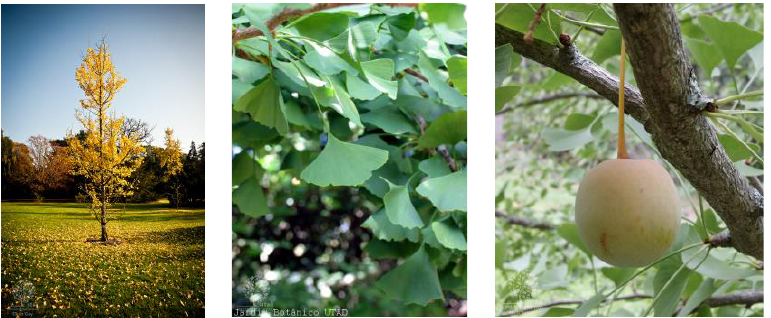
Figure 1. Ginkgo biloba tree: general appearance (autumn foliage; left); leaves (summer foliage; center ); seeds (right). Photographs by Chris Guy (left) and Arb O’Retum (right) from Jardim Botânico UTAD, Flora Digital de Portugal (https://jb.utad.pt, accessed on 21 October